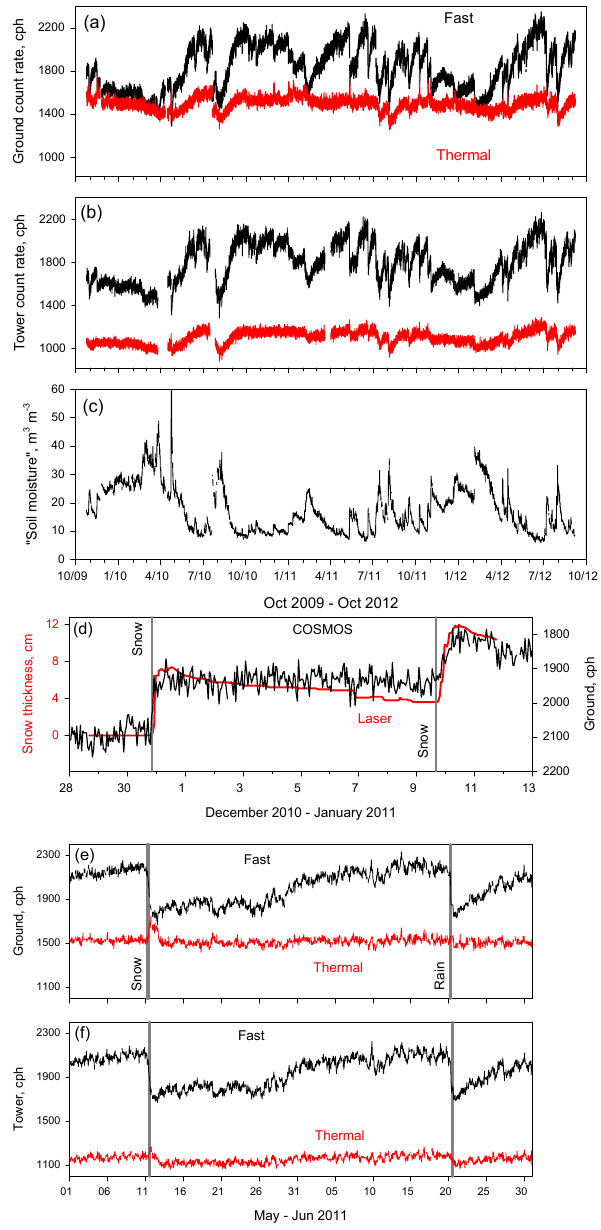
Fig. 13. Neutron intensity (cph=counts per hour) from the probe on the ground (a) and on the tower (b) , and computed “soil moisture” at the Manitou COSMOS site (c) . “Soil moisture” includes any snow that might have been present on the ground or on canopy. Snow sig- nal in cosmic-ray neutron intensity and snow thickness measured with a laser snow sensor (d) , courtesy of Dave Gochis, NCAR. Re- sponse of fast and thermal neutrons to snow and rain events on the ground and above canopy (e, f) .